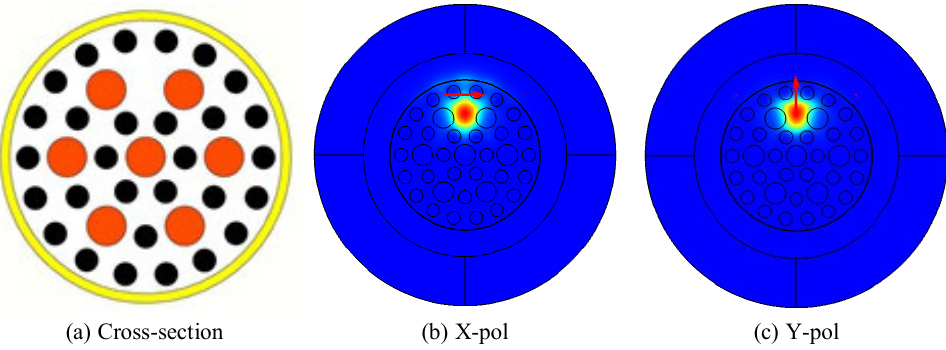
Figure 2. ( a ) Cross-section of the photonic crystal fiber with a circular lattice. The optical field distribution of the core mode for the x-polarization ( b ) and y-polarization ( c ). The base material of PCF is silica, whose refractive index is determined by the Sell- imeier equation, as shown in (6). The dielectric constant of the ITO film is described by expression, ε ∞ = 3.8 denotes the dielectric constant when the frequency is infinitely large, and λ p = 5.6497 × 10 − 7 m and λ c = 11.21076 × 10 − 6 m represent the plasma wavelength and electron collision wavelength, respectively. There is a linear relationship